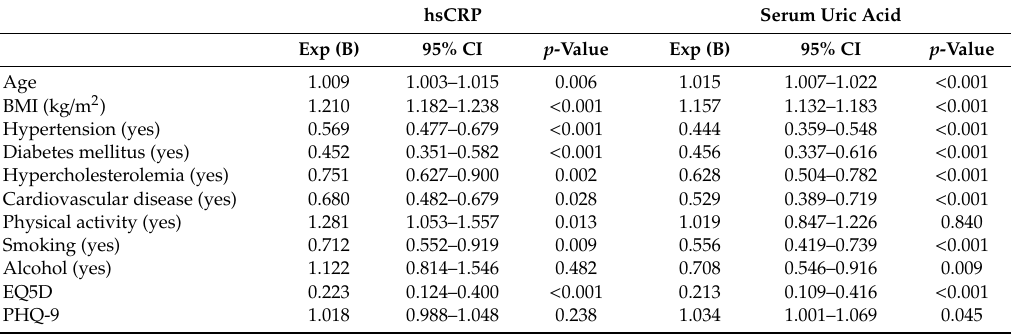
Table A1. Univariate analysis: Factors associated with hsCRP and